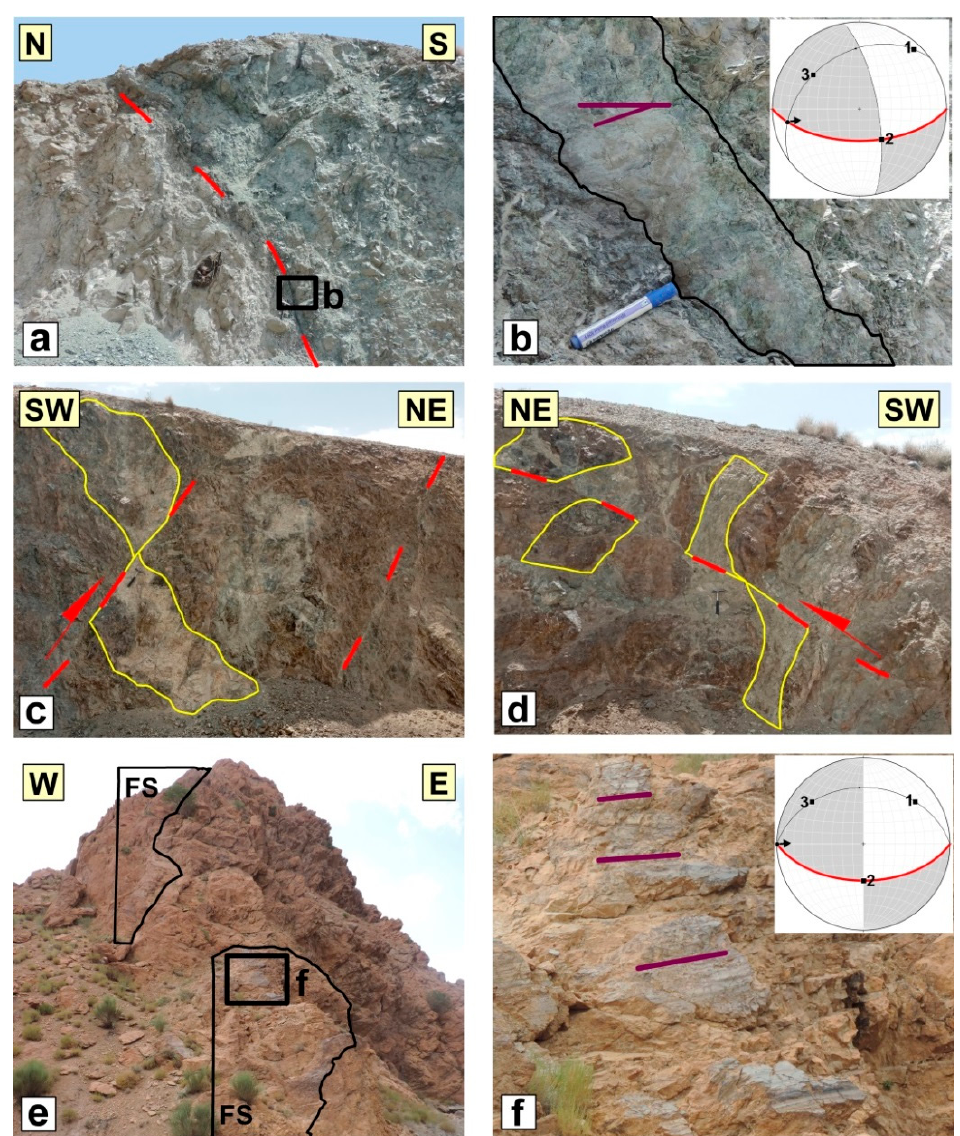
Figure 7. Structural evidence of the Kakhki and Chenesht faults. ( a , b ) The Kakhki fault plane (N90°W, 60°S) and its slicken line (260°/17°). ( c , d ) Reverse offsets of the rock units by the eastern segment of the Chenesht fault. ( e , f ) The fault planes of the western segments of the Chenesht fault (N90°E, 55°S) and their slicken line (270°/00°).